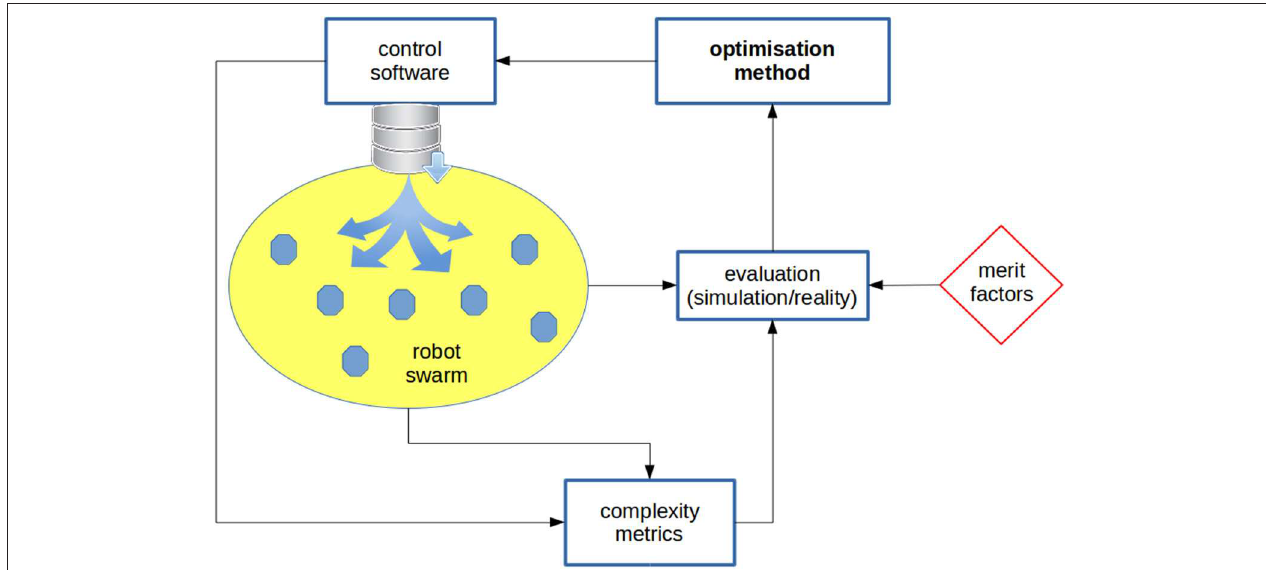
FIGURE 1 | Generic design cycle: the control software is deployed onto the robots, which are then evaluated; on the basis of the evaluation, some parameters of the control software are changed by means of an optimization method. Complexity metrics are fed into the evaluation block. Off-line design: robots are evaluated in simulation. The metrics can be used as a regularization component of the fitness function used in the evaluation block: besides a fitness component accounting for the performance of the swarm on the specific task, a further component can be added to penalize (i) individual robots or (ii) swarms that exhibit a complexity level not complying with the requirements. In the first case, the average predictive information (PI) of the robots can be taken, whilst in the second case the average pairwise mutual information can be used (see Figure 2 ). Alternatively, a multi-objective approach can be chosen, in which the swarm performance and the complexity metric are the two criteria considered in the optimization process. In this latter case, the user can choose a personal trade-off between performance and complexity. Mixed off-line and on-line design: an off-line design phase is first run, in which the complexity of the swarm (or the individuals, or both) is maximized. Subsequently, an on-line design process takes place for tuning the control software parameters with the goal of specializing the swarm to the task at hand and to keep the complexity in a given range.